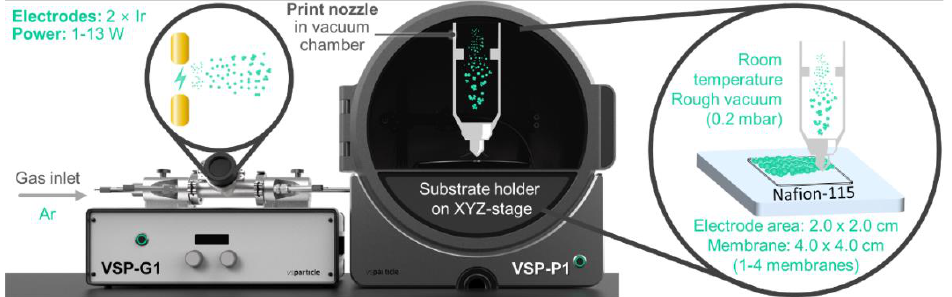
Figure 6. Schematic of VSP-P1 NanoPrinter equipped with a VSP-G1 Nanoparticle Generator, used to fabricate the spark-ablation